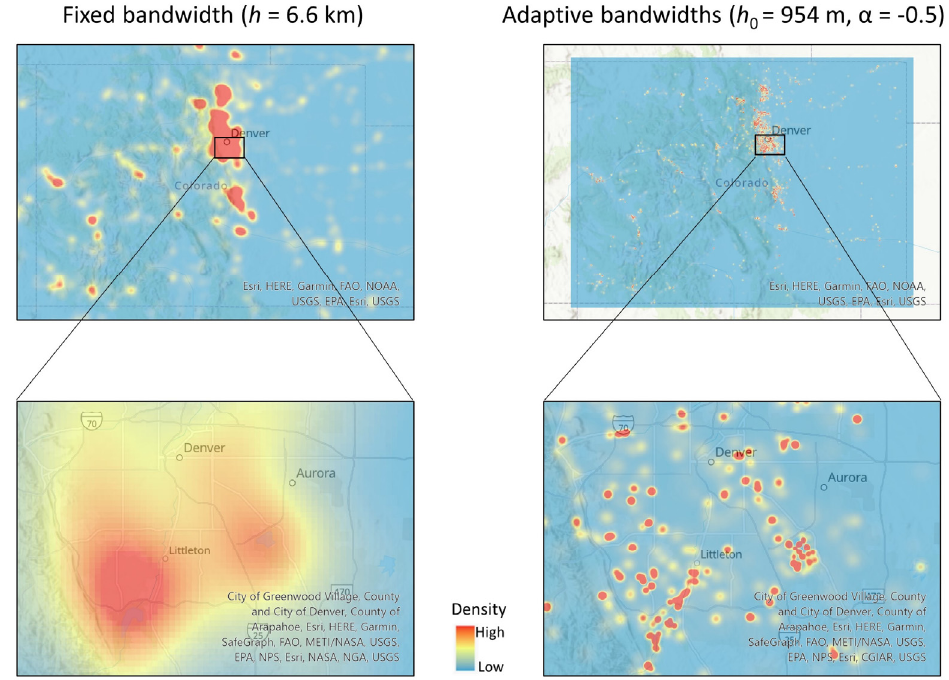
Figure 10. Comparison of the density map estimated with fixed bandwidth (cross-validation) and adaptive bandwidths in Colorado and a zoom-in area in the Denver metropolitan area.